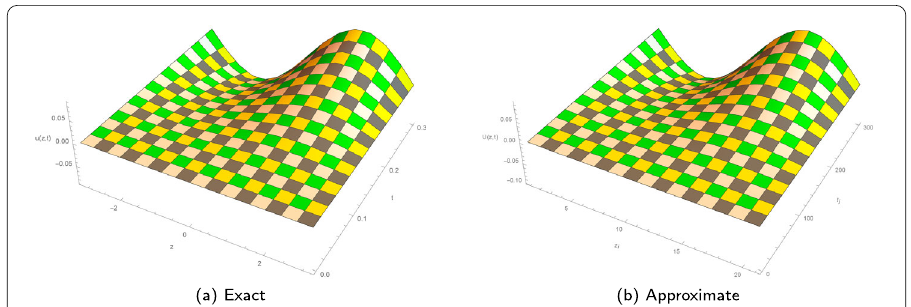
Figure 10 Exact and approximate solutions for Example 3 when N = 20, α = 0.4, t = 0.3, (cid:3) t = 0.001, and – π ≤ z ≤ π